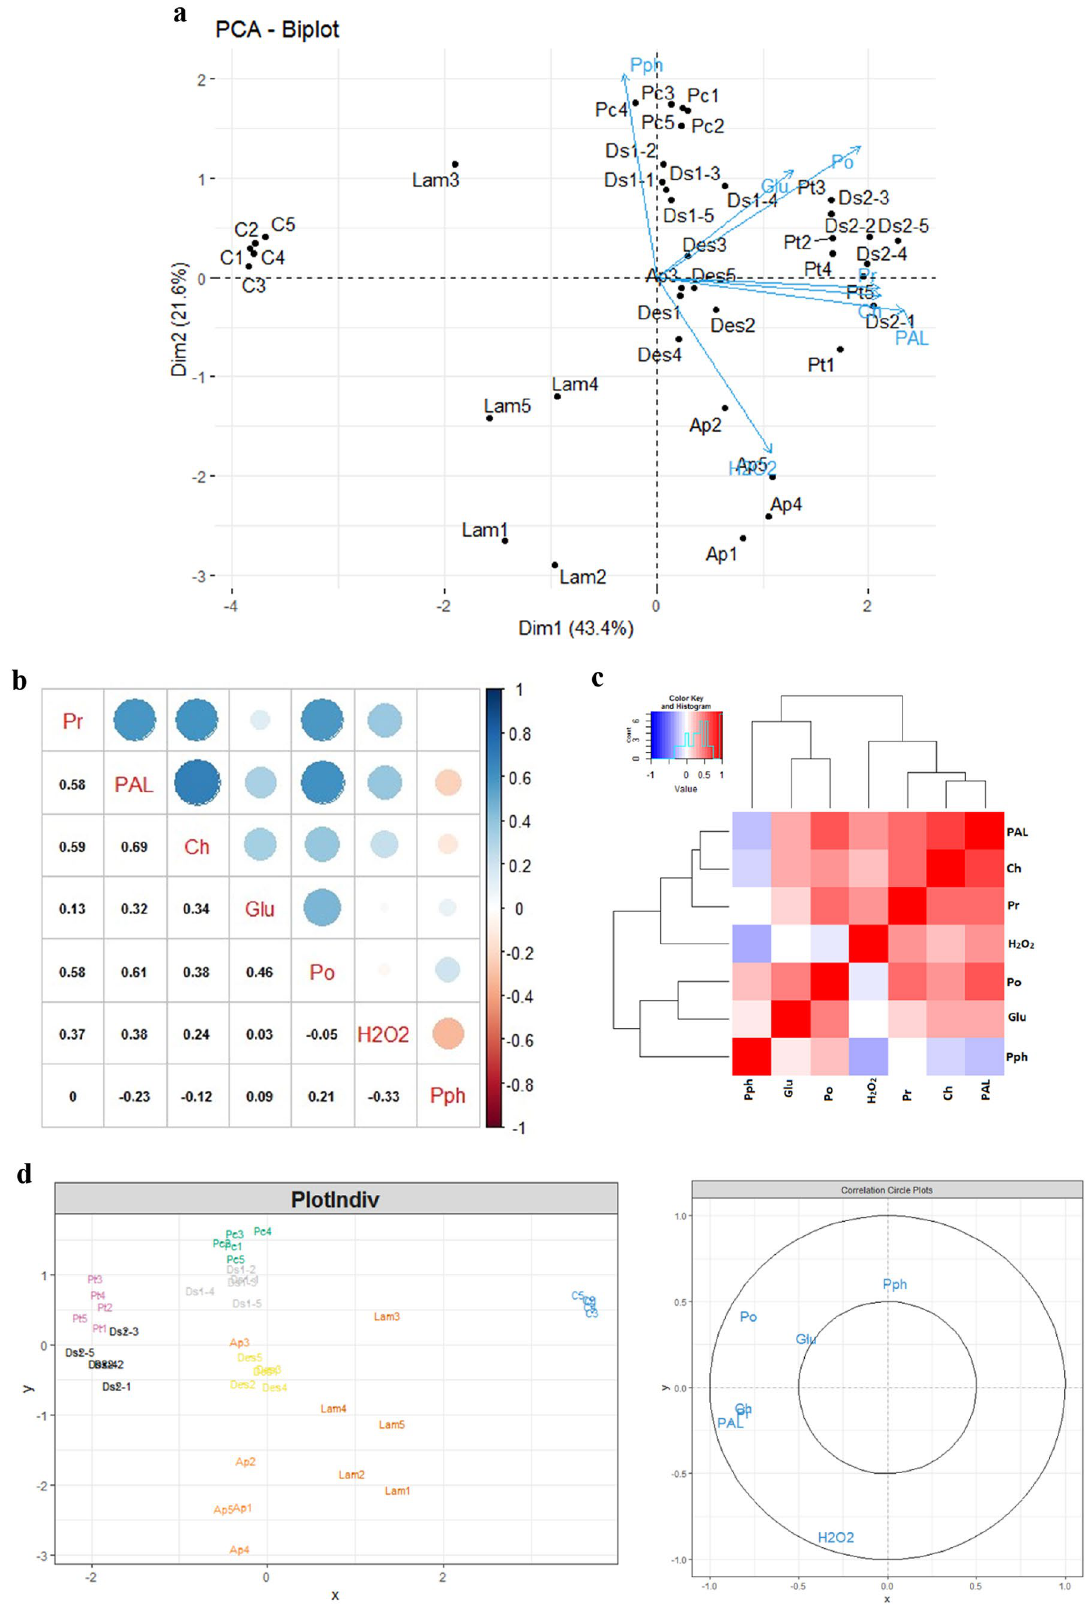
Figure 4. Biplot of principal component analysis of variables and treatments ( a ); Correlation between variables ( b ); Heatmap hierarchal clustering of studied variables ( c ); PLS-DA for biochemical variables and treatments ( d ). C: Control; A.p: A.platensis; P